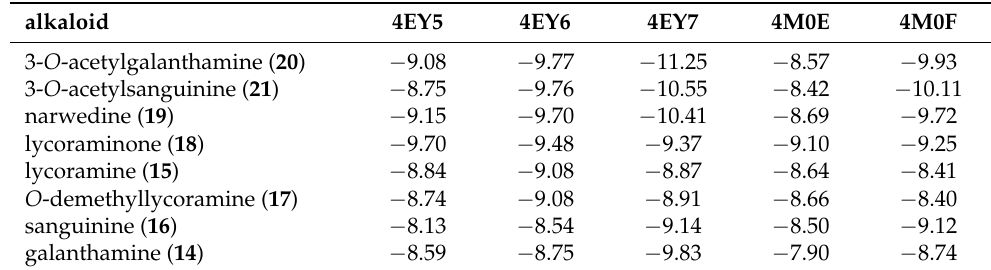
Table 2. Estimated binding free energy in molecular docking studies of alkaloids identified in the species Rauhia multiflora toward five different hAChE structures. Values are expressed in kcal · mol − 1 .